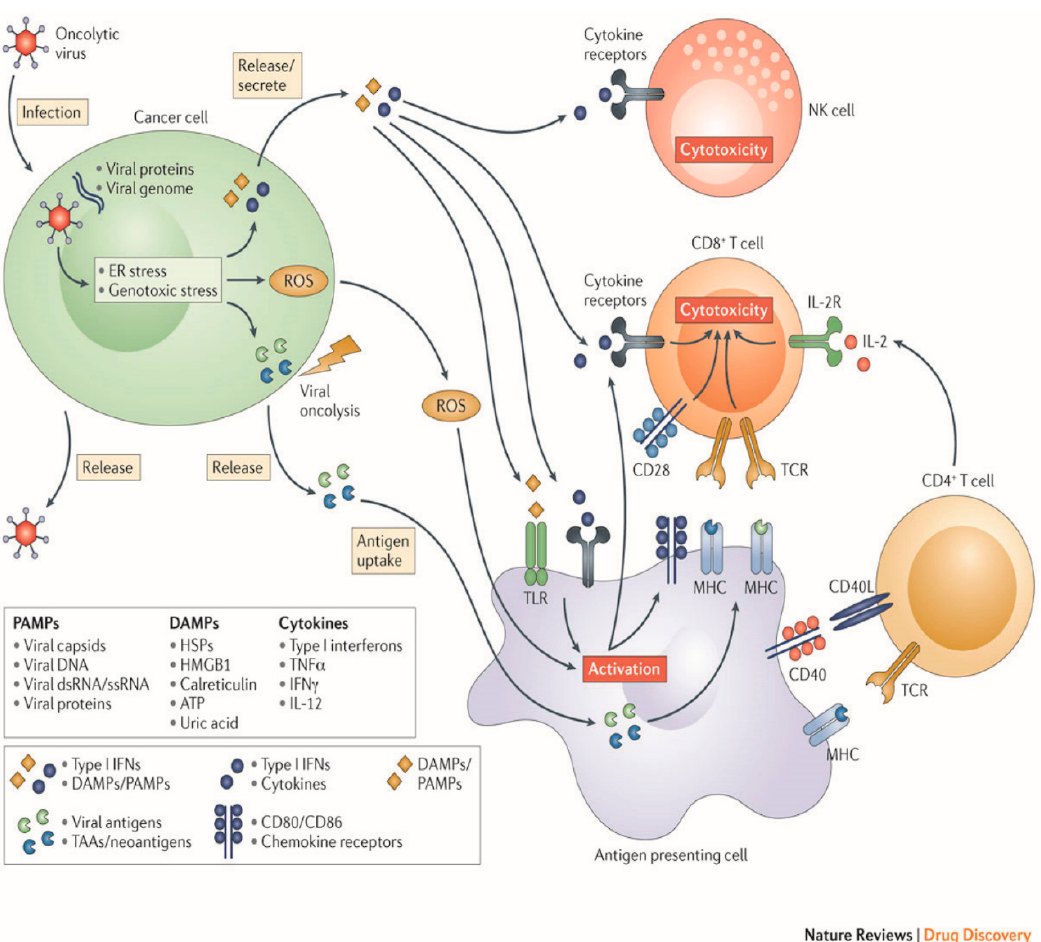
Figure 2. Mechanisms employed by oncolytic viruses. (Original image used with permission from